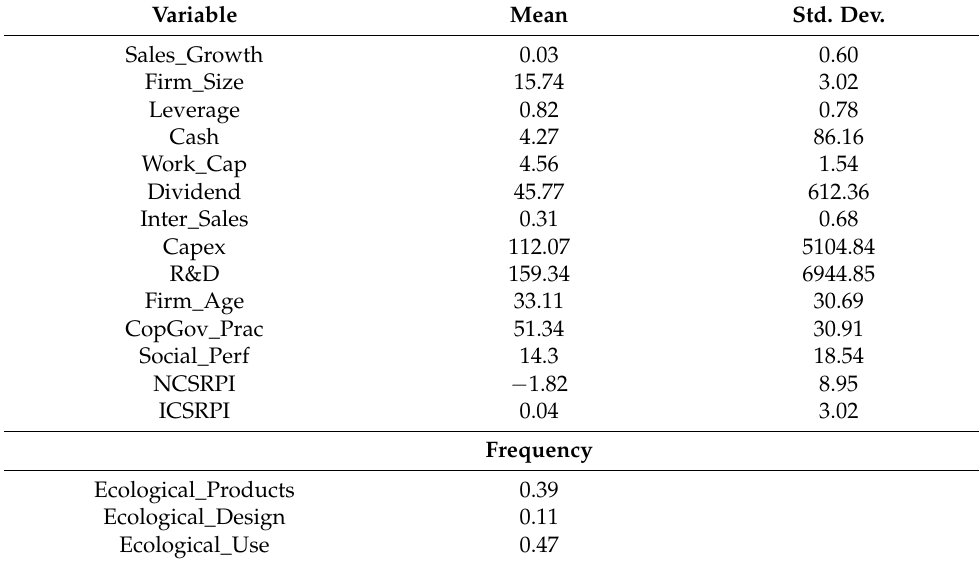
Table 2. Descriptive statistics.